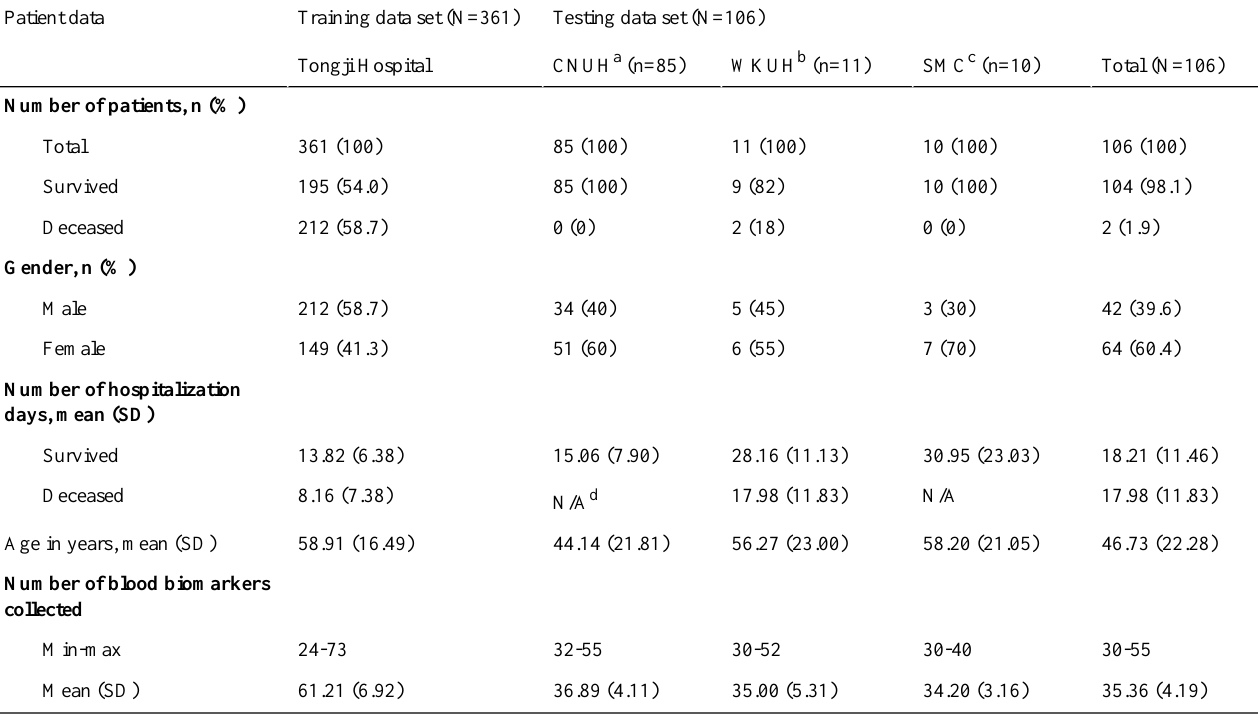
Table 1. Statistical summary of the training and testing data sets.